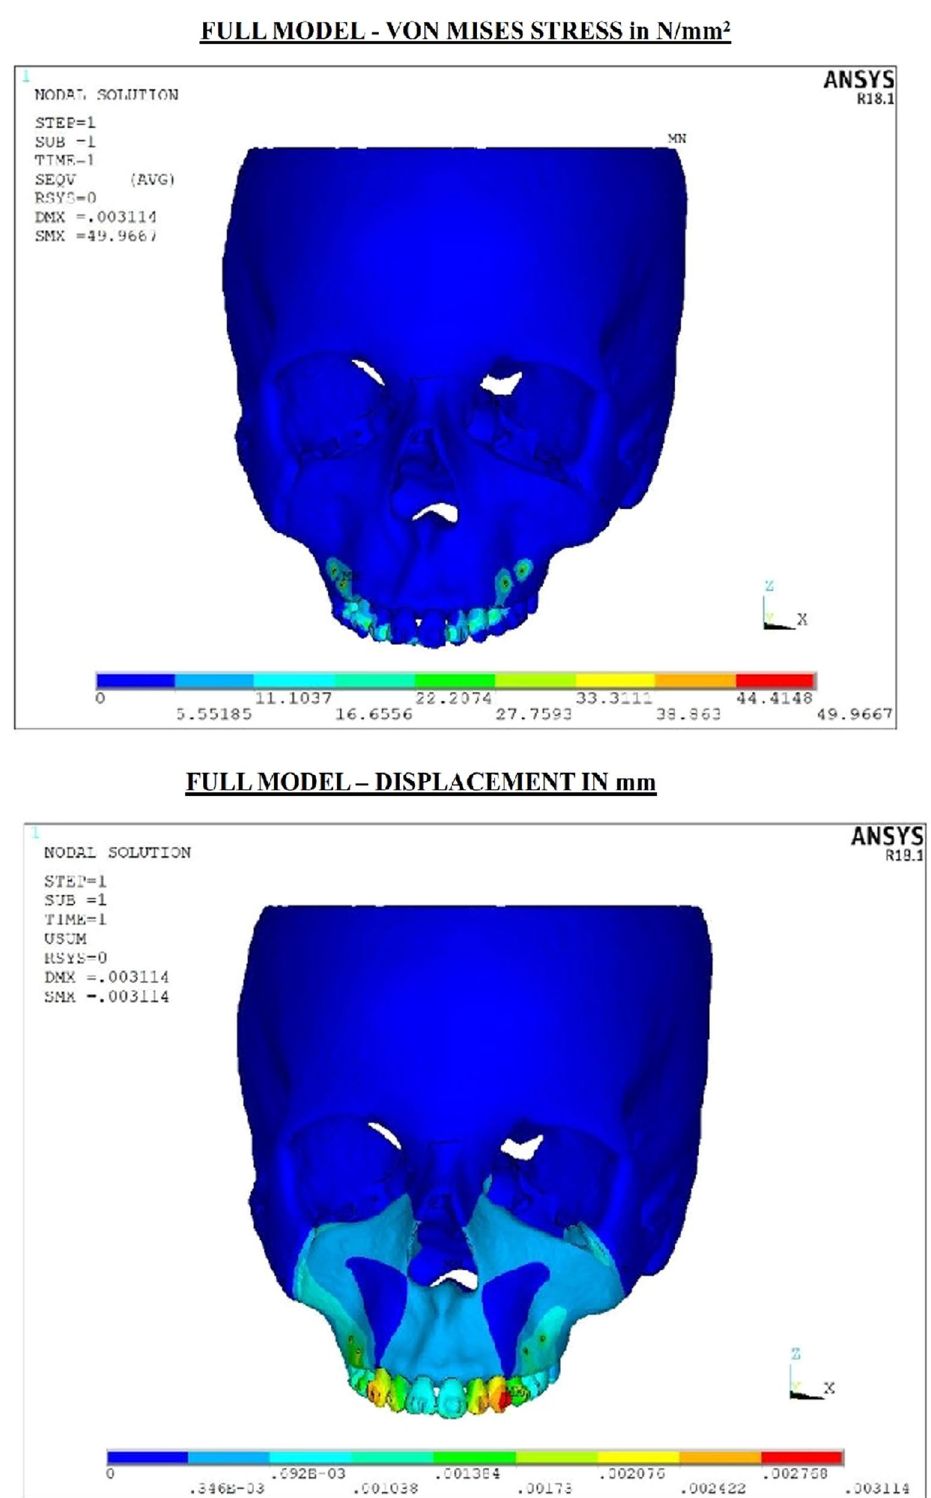
Fig. 4 Stress and displacement plots in full model with mini-implants for 500 g of